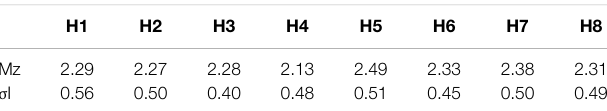
TABLE 1 | Grain-size parameters of sands in the Hobq Desert.